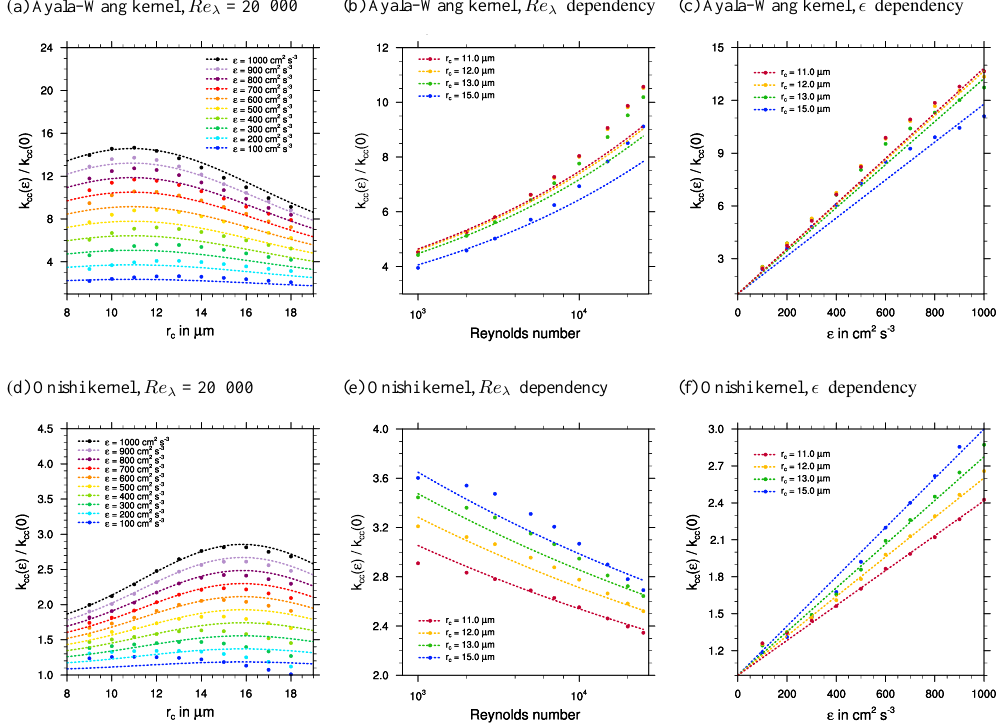
Figure 2. Enhancement factor of the autoconversion rate for the Ayala–Wang kernel (upper row) and the Onishi kernel (lower row) at Re λ = 20000 (a, c) , the Reynolds number dependency of the enhancement factor at (cid:15) = 600cm 2 s − 3 (b, d) , and the dependency on dissipation rate for Re λ = 20000 (c, f) . Data points (dots) are based on numerical solutions of the stochastic collection equation (SCE); the parameterization shown (dashed lines) is Eq. (10) with the coefficients as given in Table 1. All plots are shown for ν = 1. Note the different scaling of the y axis for both